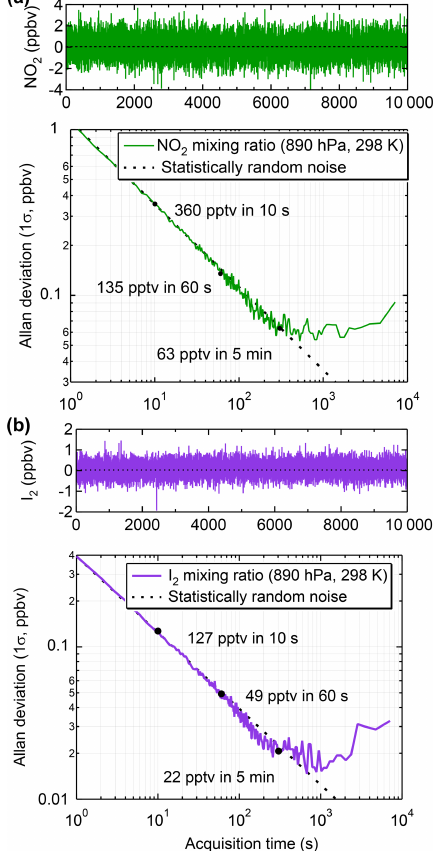
Figure 8. Allan deviation plots of data collected while the IB- BCEAS was sampling zero air to determine the optimum integration time of (a) the calculated NO 2 mixing ratios at 890hPa (1.5slpm sample rate) and 298K and (b) the calculated I 2 mixing ratios un- der the same